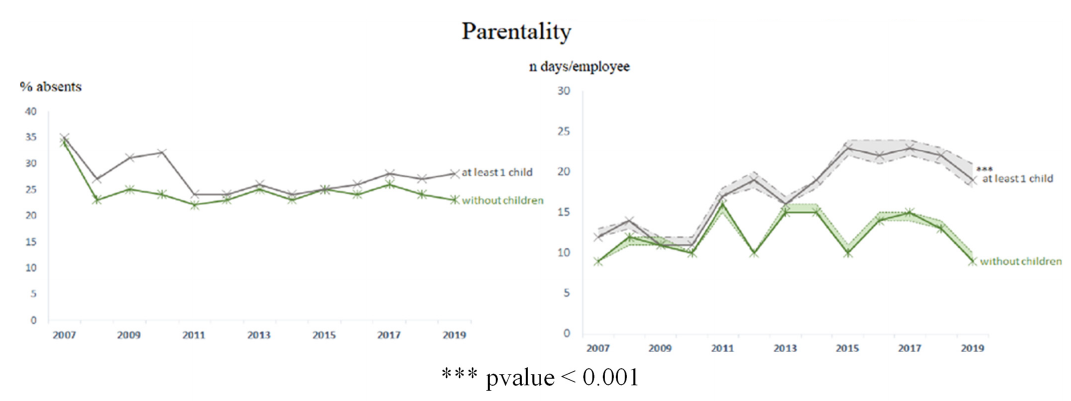
Figure 3. Evolution of the proportion of absentees and the number of days of absence per absent agent by sociodemographic factor (expressed in median (C49–C51)).